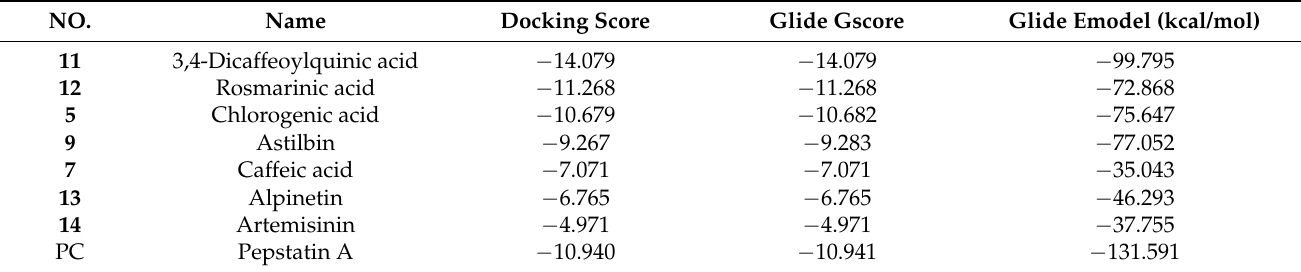
Table 6. Docking active compounds from SG extracts against HIV-1 PR (PDB ID: 1QBS).